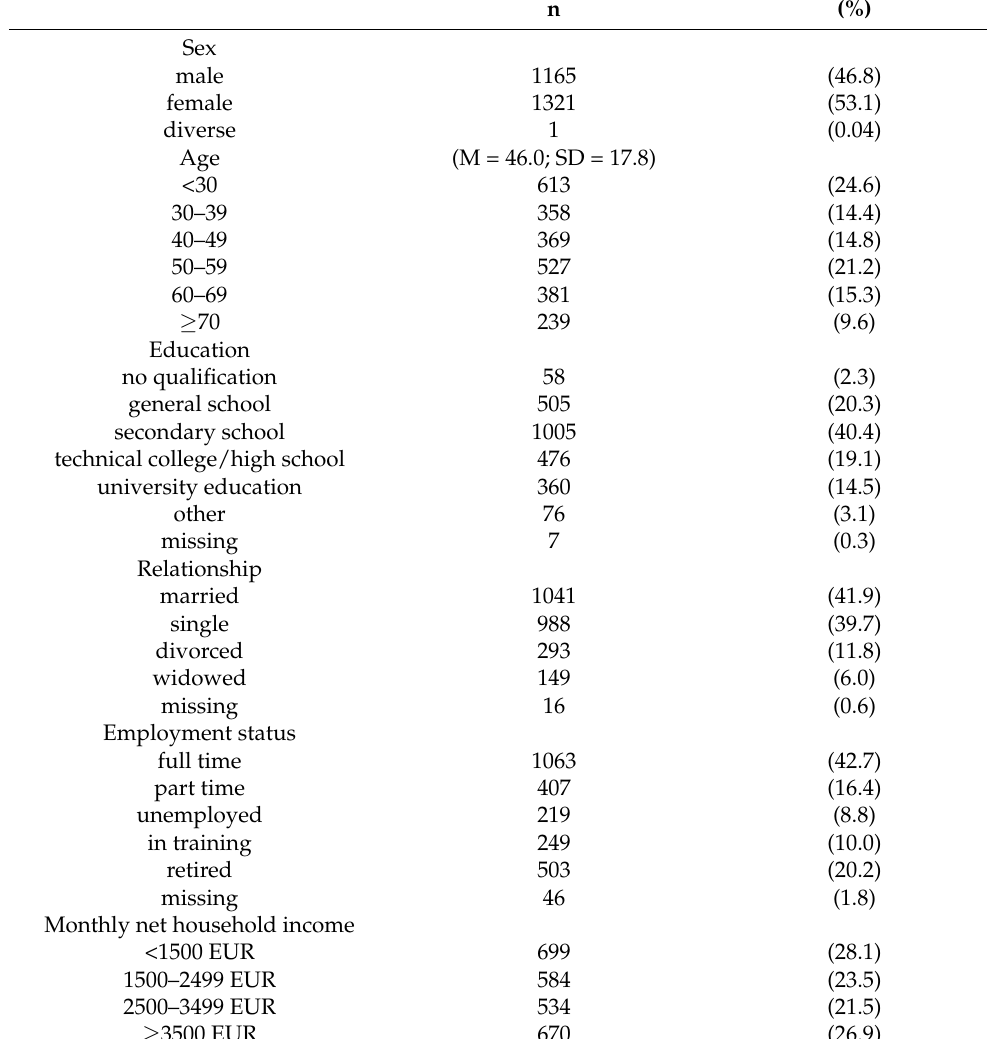
Table 1. Sociodemographic data (N =